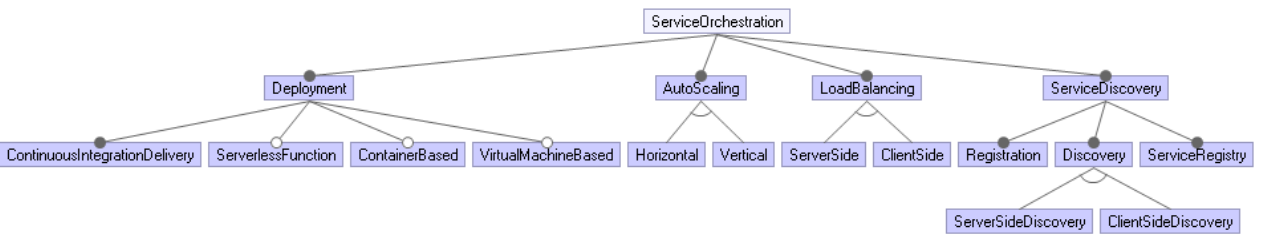
Figure 6. Feature diagram of service orchestration.